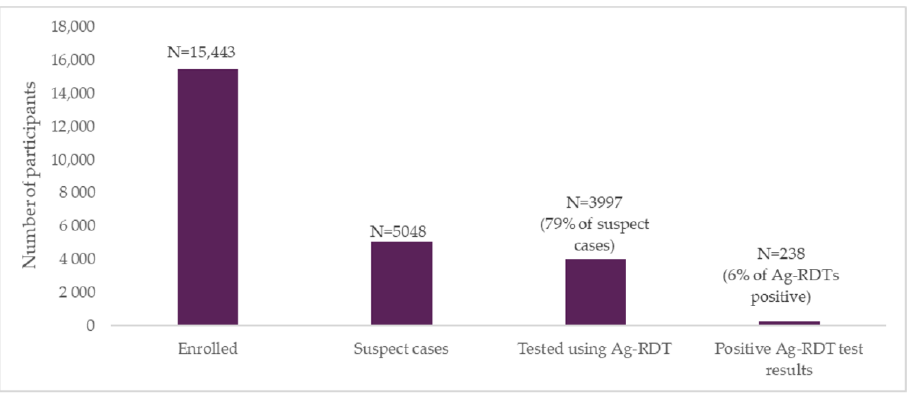
Figure 2. Percentage of participants reporting COVID-19 risk factors. Positive contact refers to close contact with a known COVID-19 positive individual.